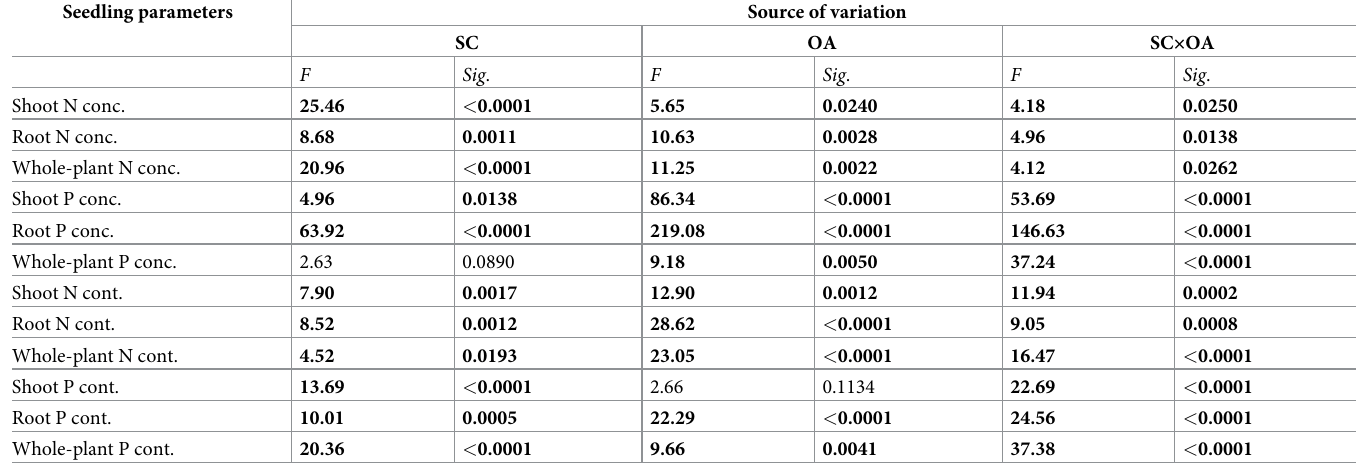
Concentrations of N and P Combined spectrum and Cos treatments showed a significant effect on concentrations of N and P (Table 3). Seedlings exposed to the spectrum of blue light with both Cos and water sprays had higher N concentration in shoots than those in the spectrum of red light (Fig 5A). In the spectrum of green light, seedlings with Cos spray also showed higher N concentration in shoots than those with water spray. Root N concentration was higher in seedlings subjected Table 3. ANOVA of spectral condition (SC), oligosaccharide spray (OA), and their combination (SC × OA) on concentrations (conc.) and contents (cont.) of nitro- gen (N) and phosphorus (P) in Podocarpus macrophyllus seedlings. Seedling parameters Source of